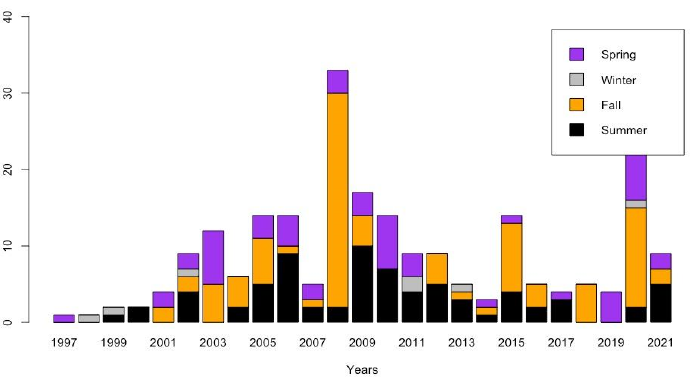
Figure 4. Number of stranded leatherbacks observed during the 25 years of the study (1997–2021), grouped by seasons (n = 223). Summer in black (n = 72), Fall in orange (n = 91), Winter in grey (n = 7), and Spring in purple (n = 53).